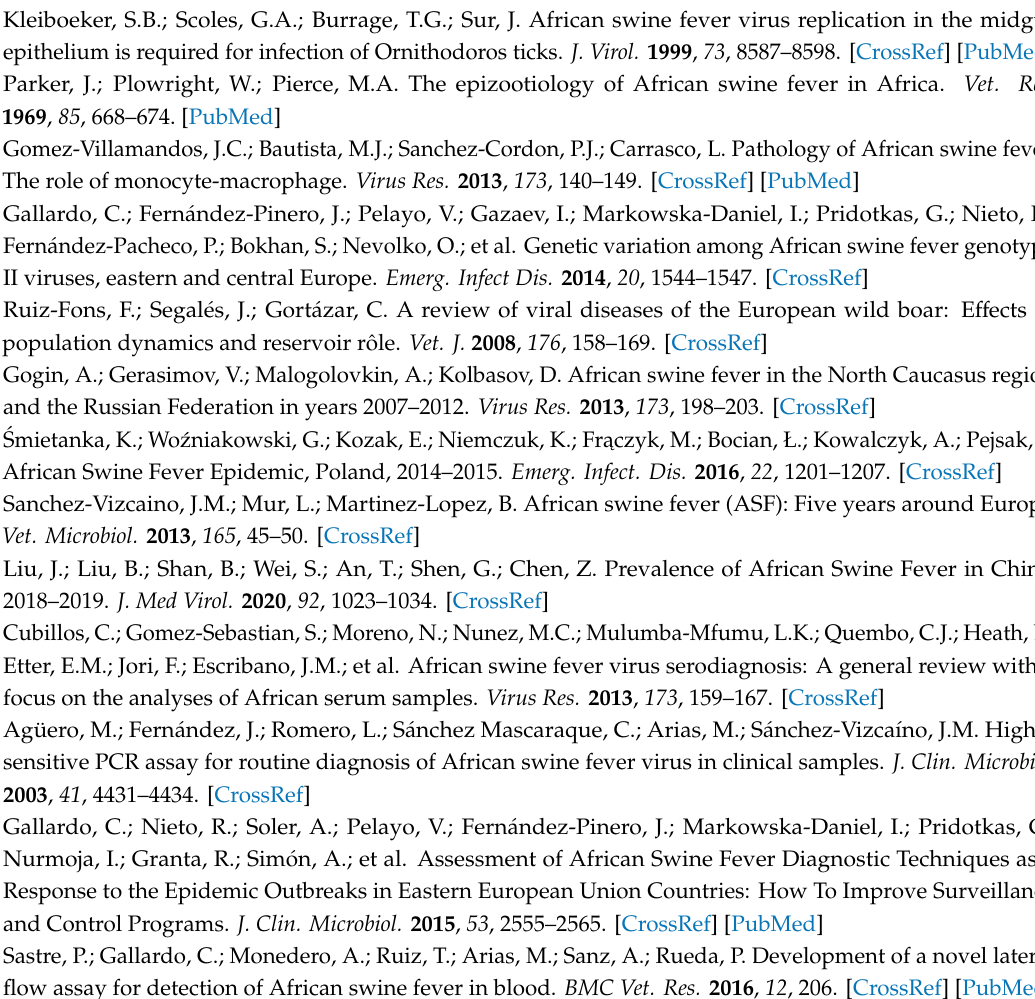
Figure S2: Fluorescence-based assay using di ff erent concentrations of recombinant plasmids, Figure S3: Selectivity assay using di ff erent strains co-incubated with ASFV, Figure S4: PCR amplification confirmation of 6 ASFV clinical